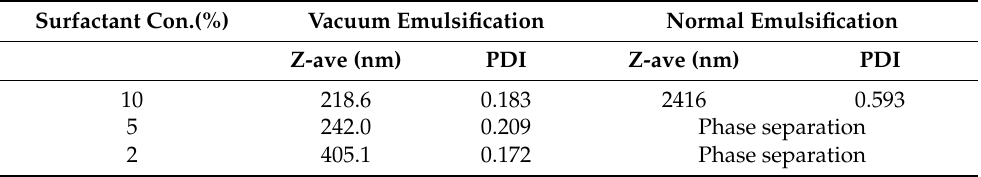
aggregated again with a small amount of surfactant (Figure 1) [29]. Table 2. Mean diameters (Z-ave) and polydispersity index (PDI) values of retinol-loaded lipid nanoparticles according to the decreasing surfactant concentrations in vacuum emulsification and normal